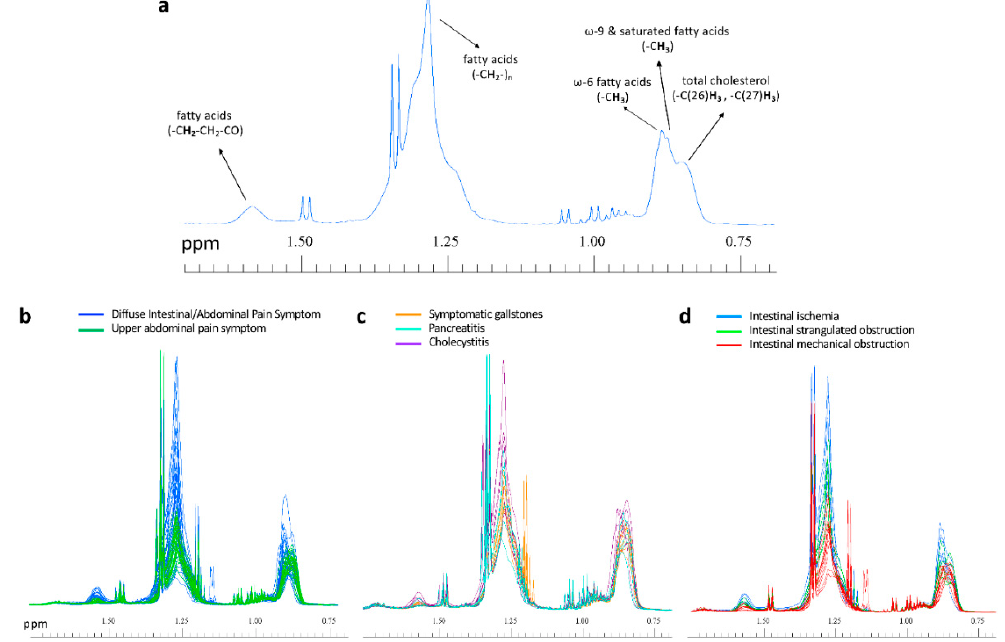
Figure 4. ( a ) NMR spectral region of a serum sample, focusing on the signals of aliphatic protons from fatty acids and total cholesterol (see Section 4.3 of the manuscript for the assignment details). ( b – d ) All spectra employed for the studied groups of symptoms and diseases, colored accordingly and focused on the NMR regions of fatty acids and total cholesterol.